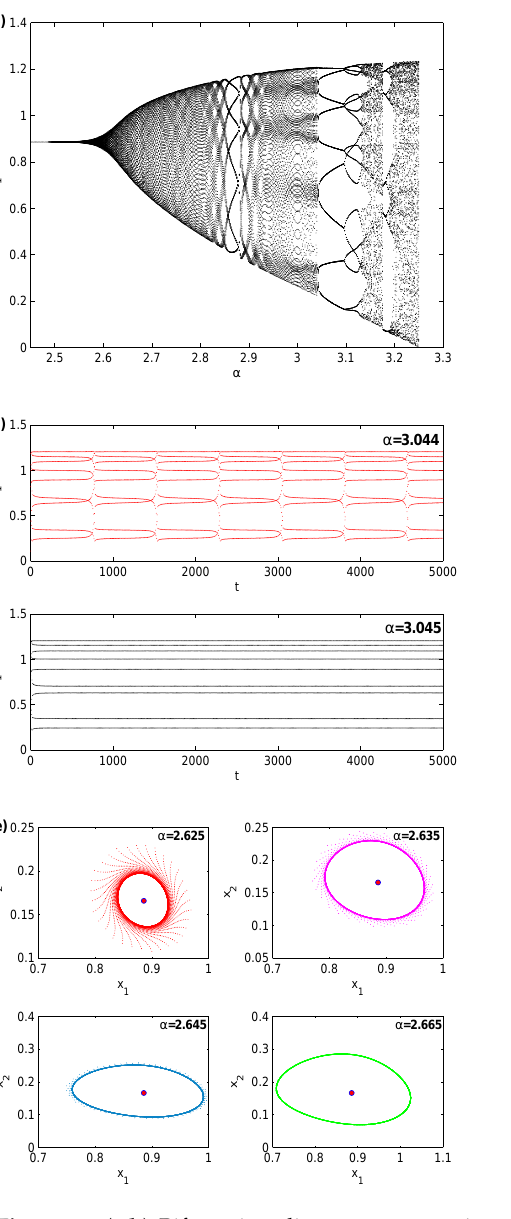
Figure 2. ( a , b ) Bifurcation diagrams on varying α with respect to x 1 and x 2 ; ( c ) Time series for quasi-periodic and period 9-cycle; ( d , e ) Spiral and closed invariant curve; ( f ) Basins of attraction for period 9-cycle at α = 3.045. Keeping fixed the other parameters’ values at: c 1 = 0.15, c 2 = 0.9, ω = 0.5 and β =